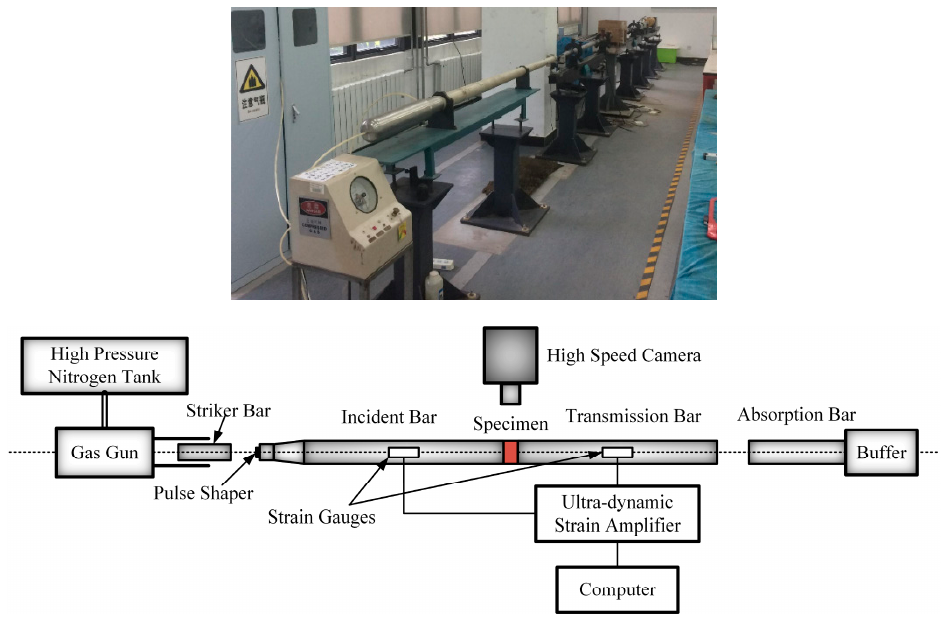
Table 2. Split Hopkinson pressure bar (SHPB) test scheme.